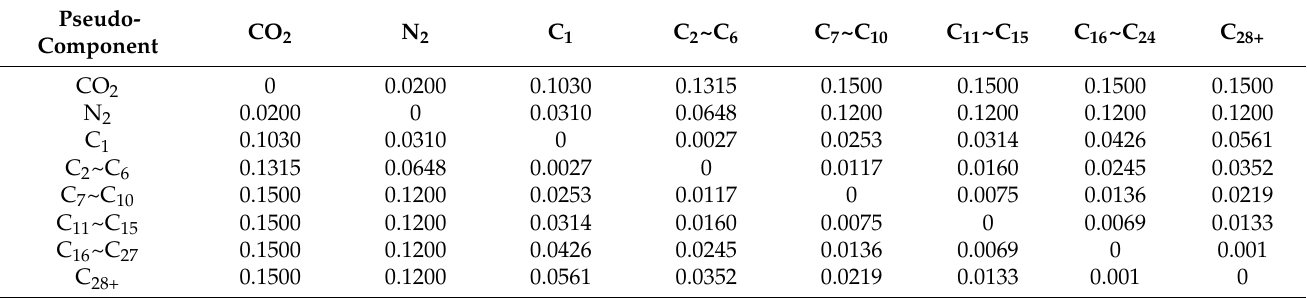
Table 4. Binary interaction parameters ( K ij ) and mixing rules for the PREOS in this